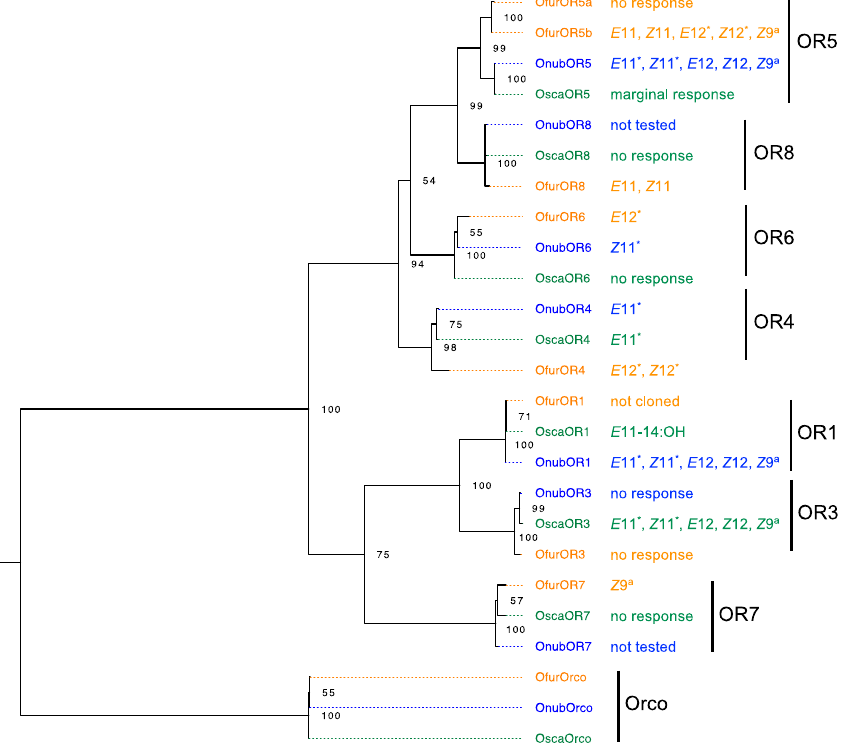
Figure 4. The phylogeny of PR genes in Ostrinia species and their ligand profiles. The amino acid sequences (Table S1) were aligned with MUSCLE [51]. The maximum likelihood tree rooted with the Orco lineage was constructed using MEGA X [52,53] with LG + G substitution model [54]. Per- centage bootstrap support (500 replicates) values over 50 are labelled at corresponding nodes. Bule,